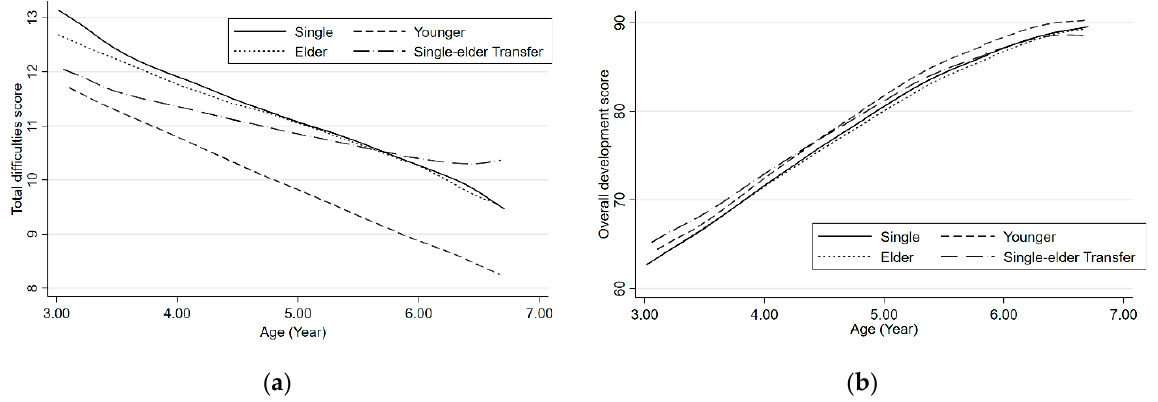
Figure 2. ( a ) Locally weighted smoothing plots for total difficulties scores by SDQ over age in the different children’s groups. ( b ) Locally weighted smoothing plots for overall development scores by eHCI over age in the different children’s groups. (Add annotations for single, younger, etc.).